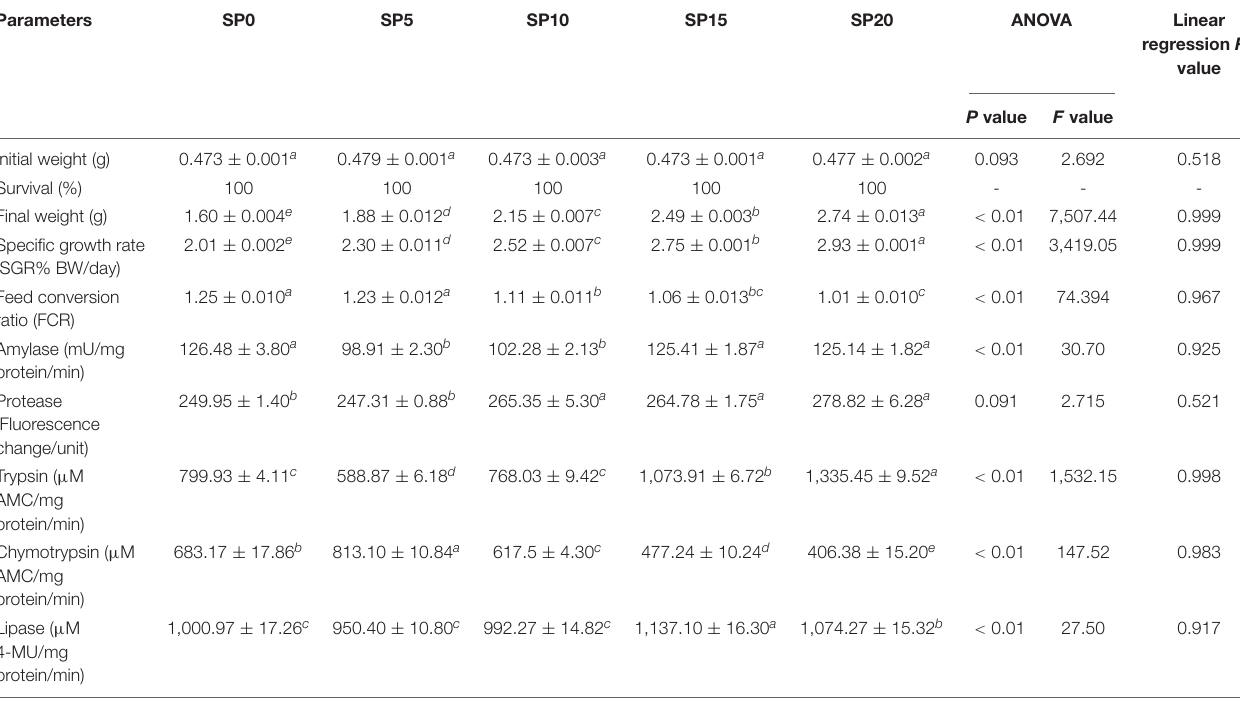
TABLE 2 | Initial weight, survival rate, final weight, specific growth rate, feed conversion ratio, and digestive enzyme activities of Cyprinus carpio fed five different